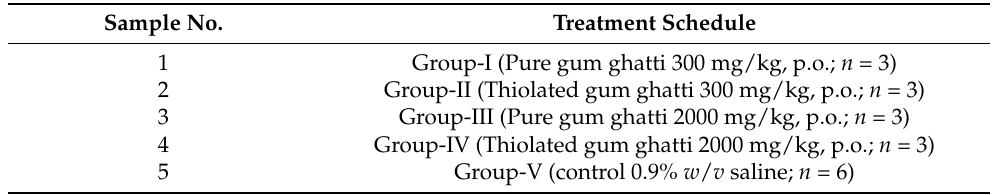
Table 1. Treatment schedule for acute oral toxicity studies of pure gum ghatti and thiolated gum ghatti.